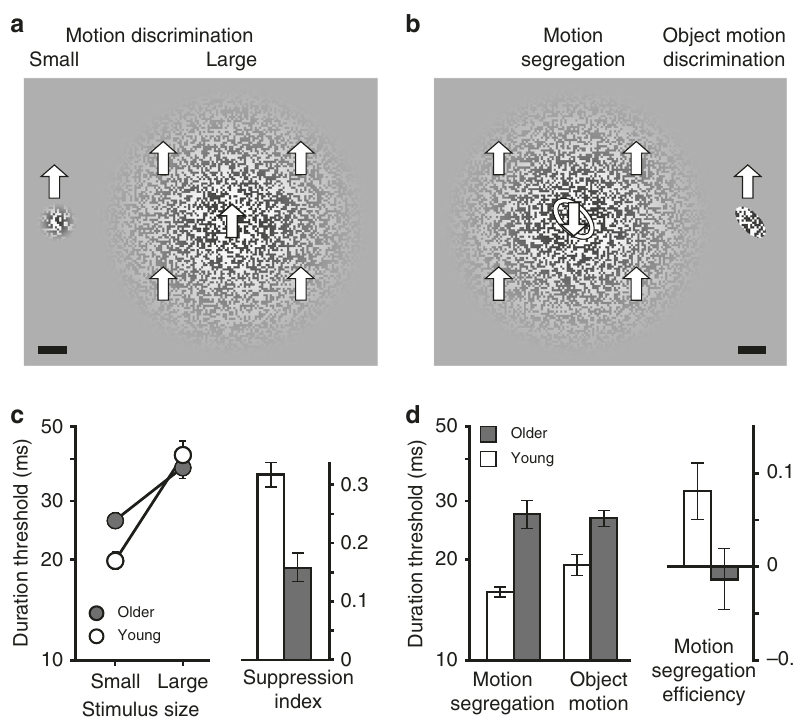
Fig. 3 Age-related changes in spatial suppression and motion segregation. In separate blocks, observers discriminated motion directions (up vs. down) of small and large stimuli ( a ), and that of an oval object ( b , right). In the motion segregation task ( b , left), observers identi fi ed the orientation of a motion- de fi ned object (left tilt vs. right tilt). Block arrows and the object outline are shown for illustration purposes only. Scale bar is 1°. ( c ) The effect of stimulus size on motion direction discriminations in young and older adults. Suppression index is de fi ned as log 10 (large size threshold) – log 10 (small size threshold). ( d ) Motion segregation and motion discrimination of an oval shape in young and older adults. Motion segregation ef fi ciency is de fi ned as log 10 ( fi gure- motion threshold) – log 10 (motion segregation threshold). All error bars are